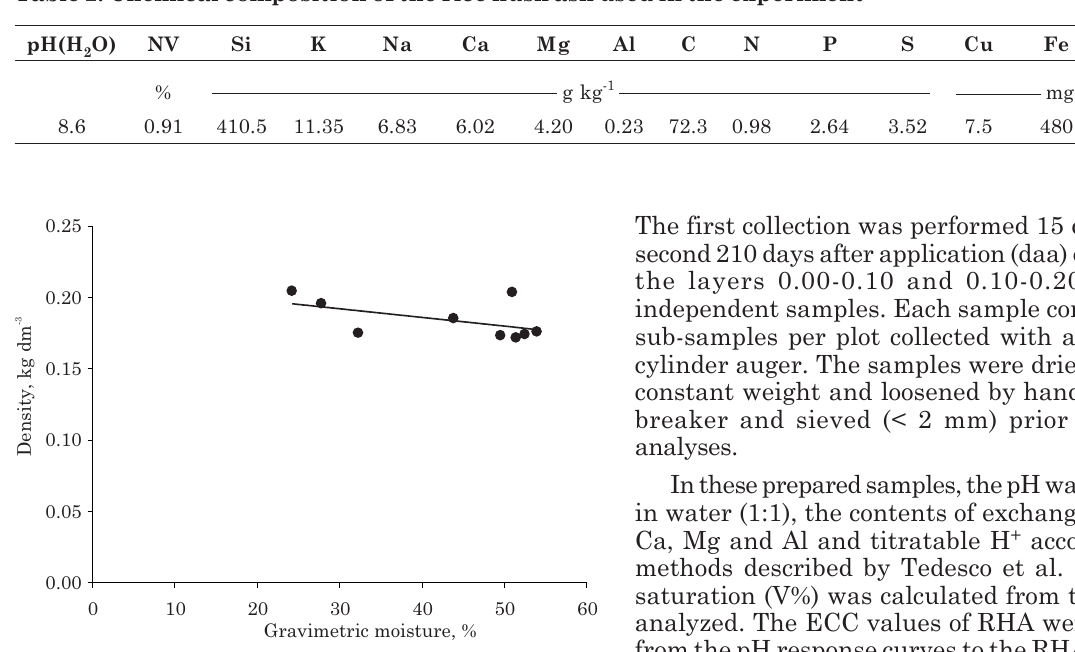
Table 2. Chemical composition of the rice husk ash used in the experiment